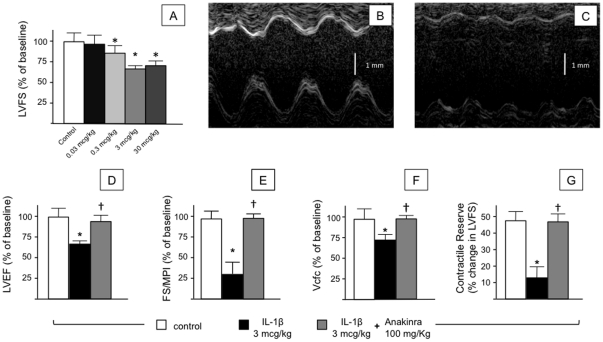
Model of IL-1-induced systolic dysfunction in healthy mice.Healthy, adult, mice underwent baseline echocardiography followed by a single intraperitoneal injection of recombinant human IL-1β (0, 0.03, 0.3, 3, or 30 mcg/kg) and subsequent echocardiography at 4 hours. (A) All doses of IL-1β ≥0.3 mcg/kg produced a significant 28 – 32% reduction in left ventricular fractional shortening (LVFS) at 4 hours. Panels B (baseline) and C (4 hours) show representative echocardiographic images at 4 hours of mice injected with 3 mcg/kg IL-1β. Panels D – F show additional measures of LV function at 4 hours: (D) LV ejection fraction (LVEF); (E) FS/myocardial performance index (MPI) or FS-Tei index; (F) velocity of circumferential fiber shortening (Vcfc) corrected for heart rate. In all experiments, pre-treatment with anakinra 100 mg/kg 30 minutes prior to IL-1β was sufficient to prevent changes in LV function. (G) Isoproterenol 0.01 mcg/kg induced a reproducible 46% increase in LVFS that was significantly blunted by pre-treatment with IL-1β 3 mcg/kg. *P<0.01 versus control/baseline; †P<0.01 versus IL-1β.